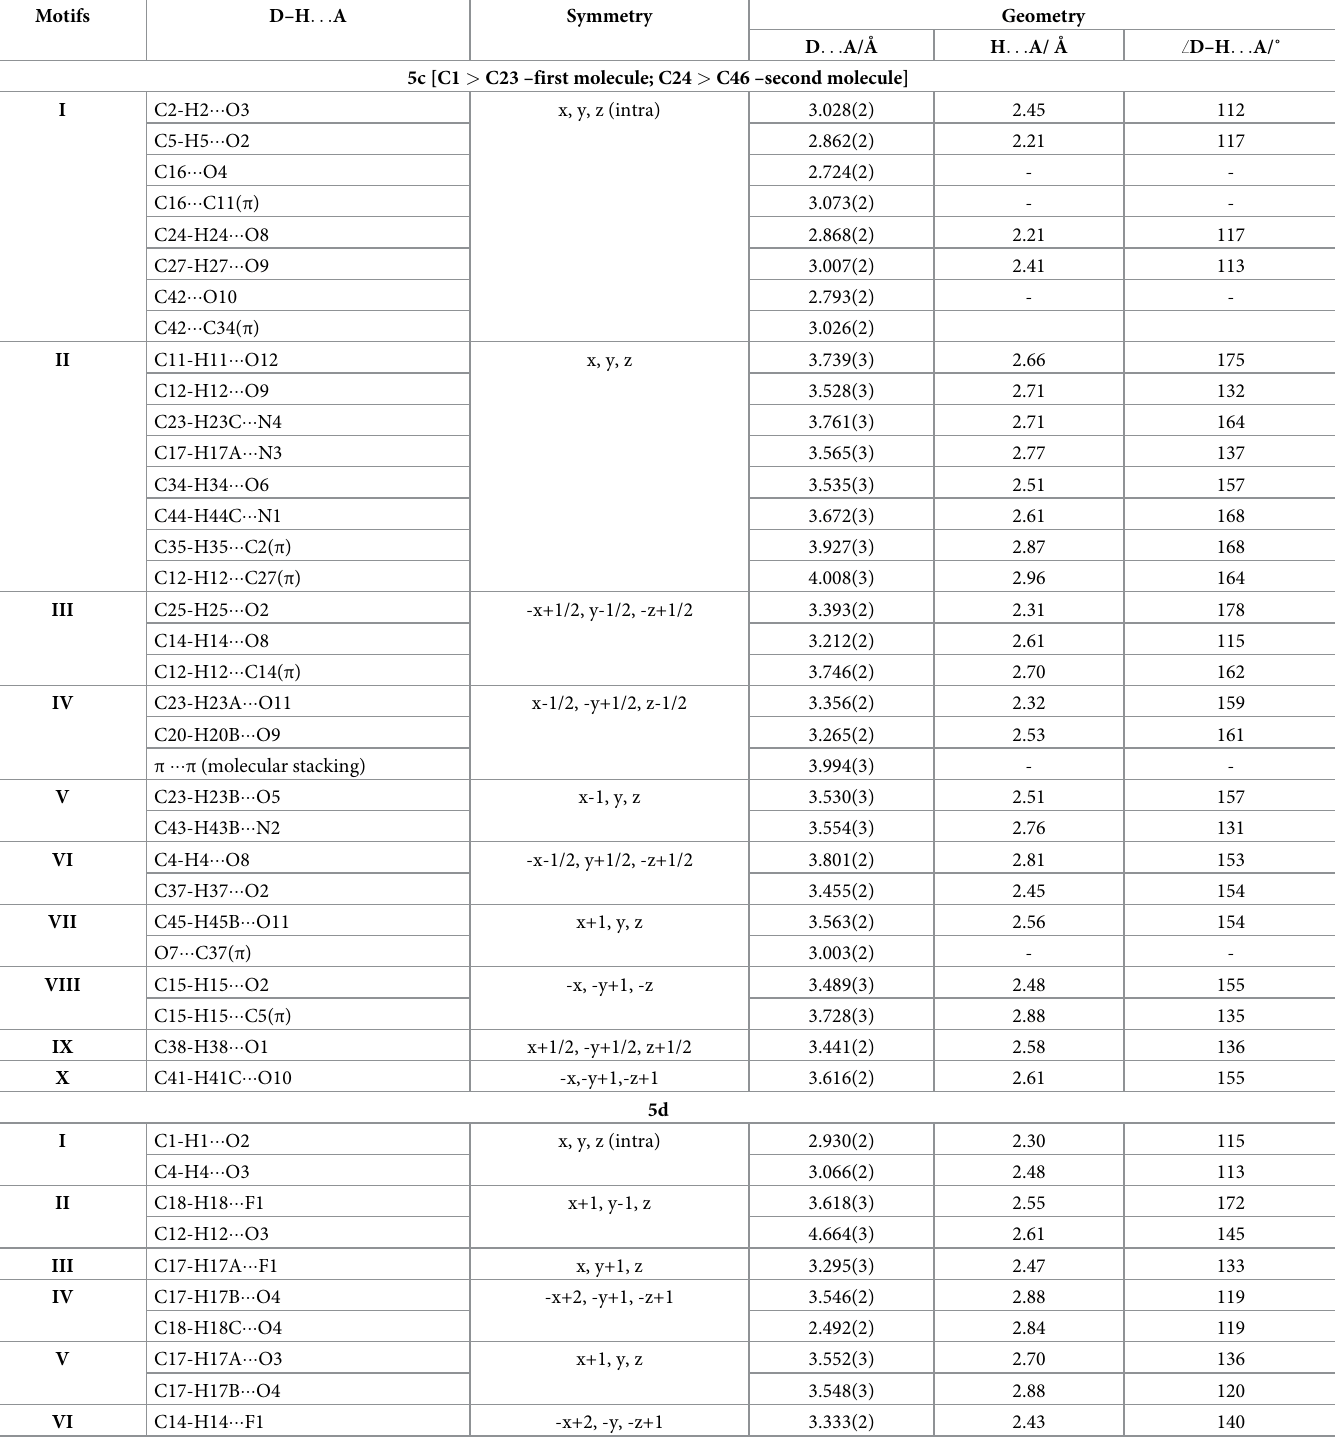
Table 4. List of intra- and intermolecular interactions present in compounds 5c and 5d.